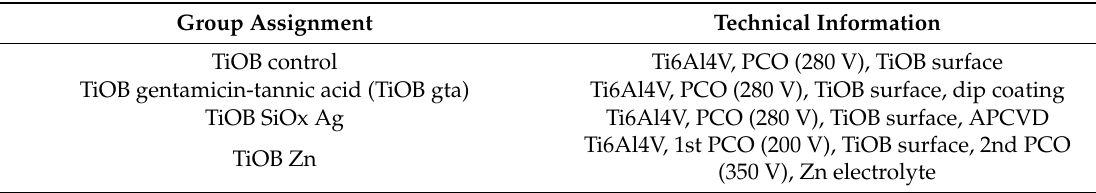
Table 1. Group assignments and technical